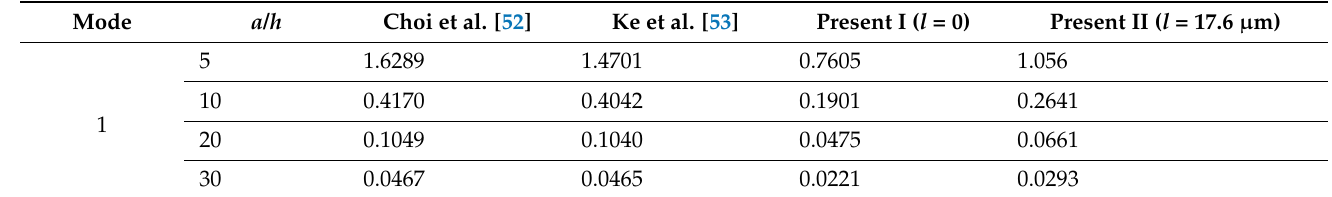
Table 2. Comparison of the natural frequencies (MHz) of homogeneous square plates ( h = 2 l